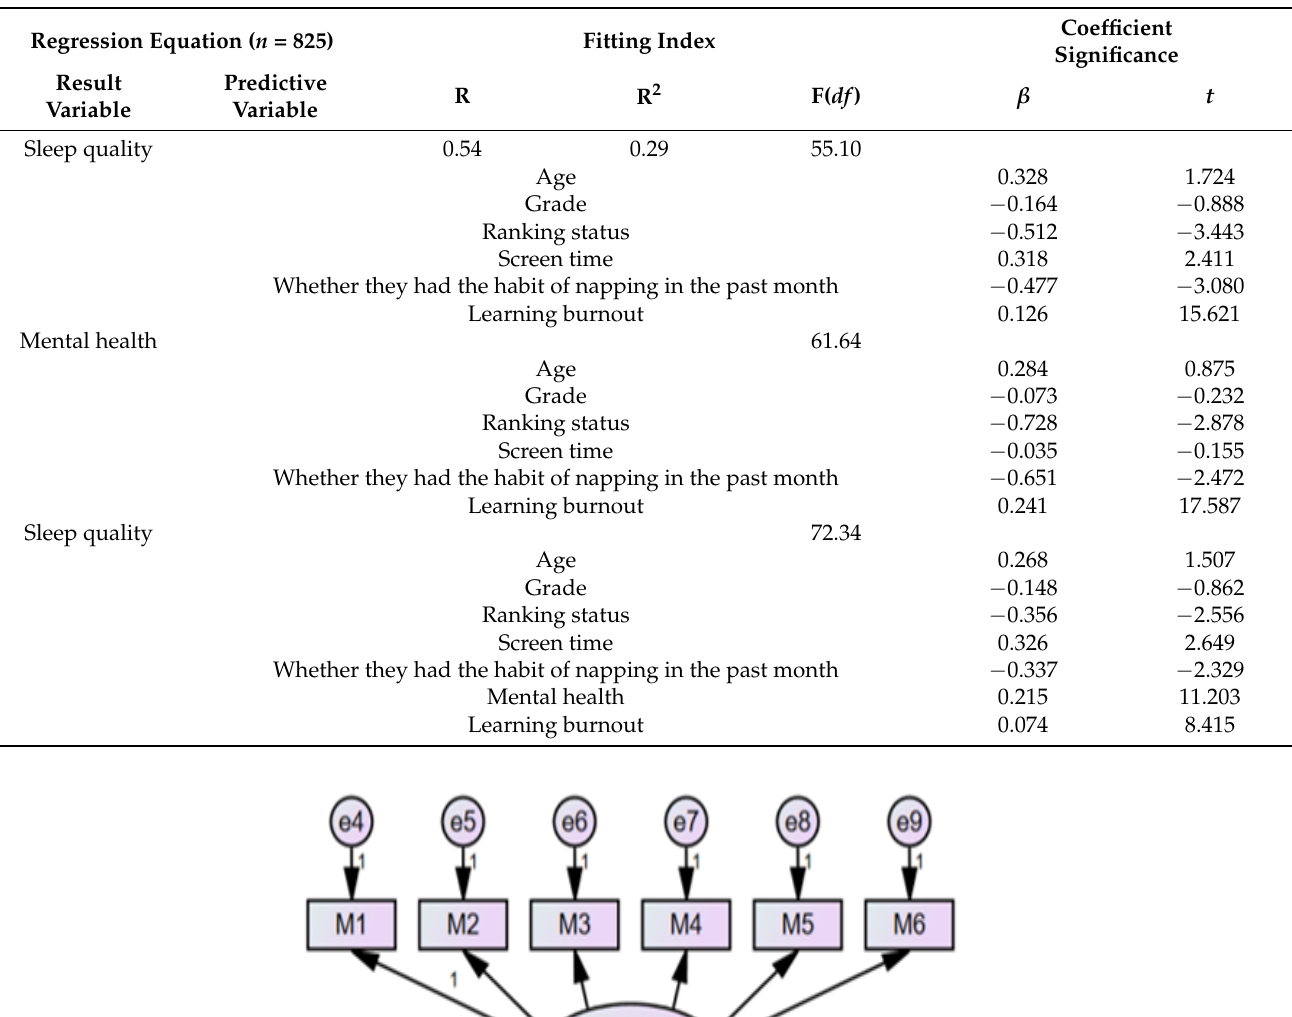
Table 4. Intermediary model test of mental health ( n = 825).